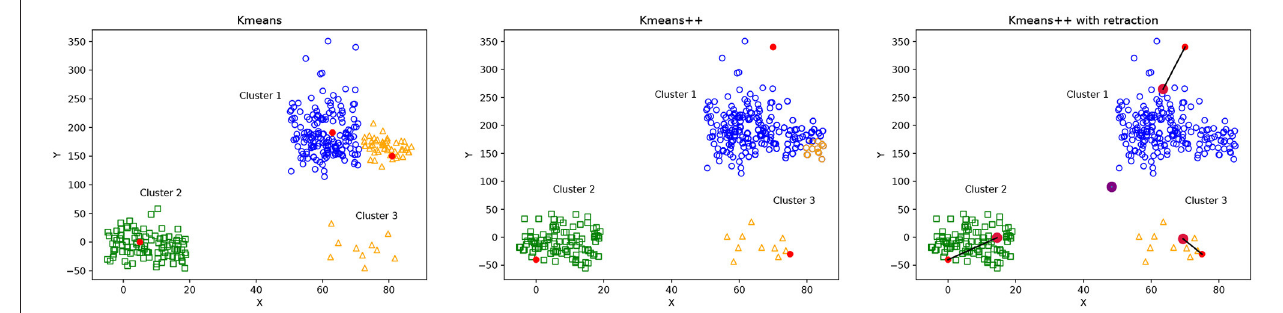
FIGURE 3 | Illustration of possible cluster formation using Kmeans, Kmeans++ and Kmeans with point retraction. Initial centroid points are shown in red. Figure on the (left) shows that random centroids for the blue and orange clusters are too close, producing an incorrect cluster formation. The figure in the (middle) shows Kmeans++ centroid initialization, where the initial centroid for the blue cluster is far away from any other point, producing a wrong classification of some points which are assigned to the orange cluster. Figure on the (right) shows Kmeans++ with point retraction which defines initial centroids that provide a better cluster formation than